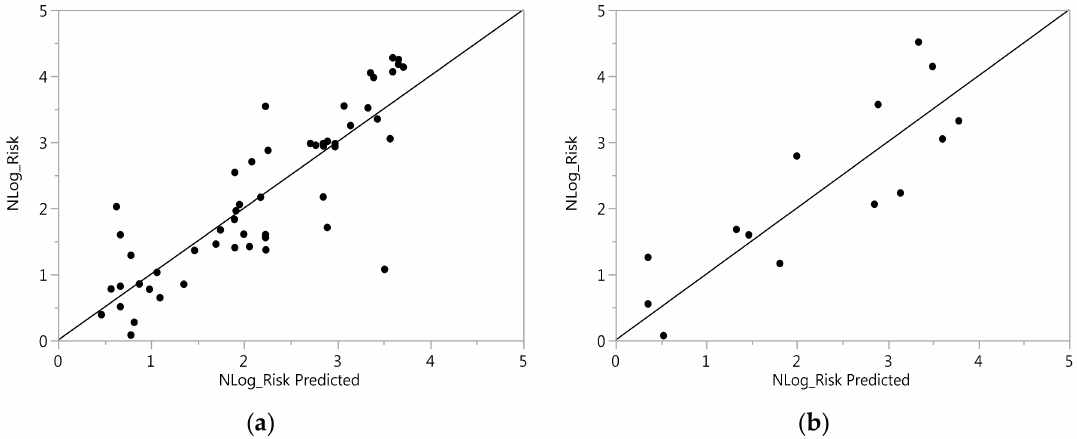
Figure 5. Actual By Predicted Plot ( a ) Training ( b ) Validation.